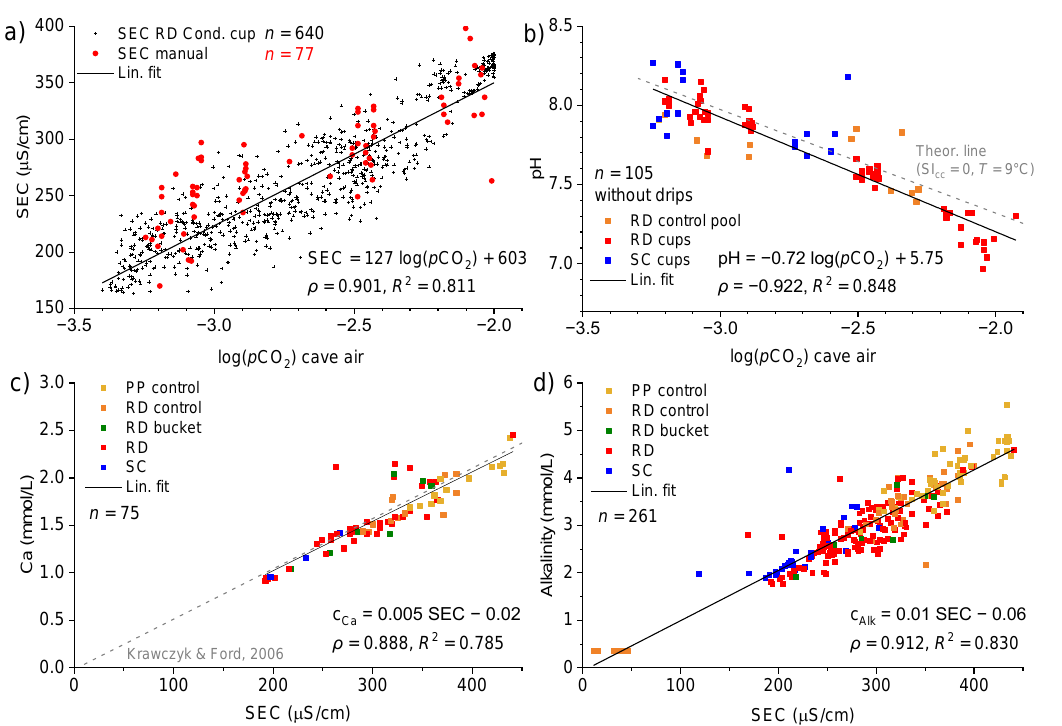
Figure 10. Correlation between the log( p CO 2 ) at the floor and the manual or continuous SEC values ( a ) or pH measurements of the cup or pool water ( b ). Correlation between the SEC and manual calcium concentrations ( c ) or alkalinity ( d ). The grey dashed line in ( c ) represents the linear regression for clean limestone waters with a low total hardness (<600 µS/cm) based on a large dataset [48].